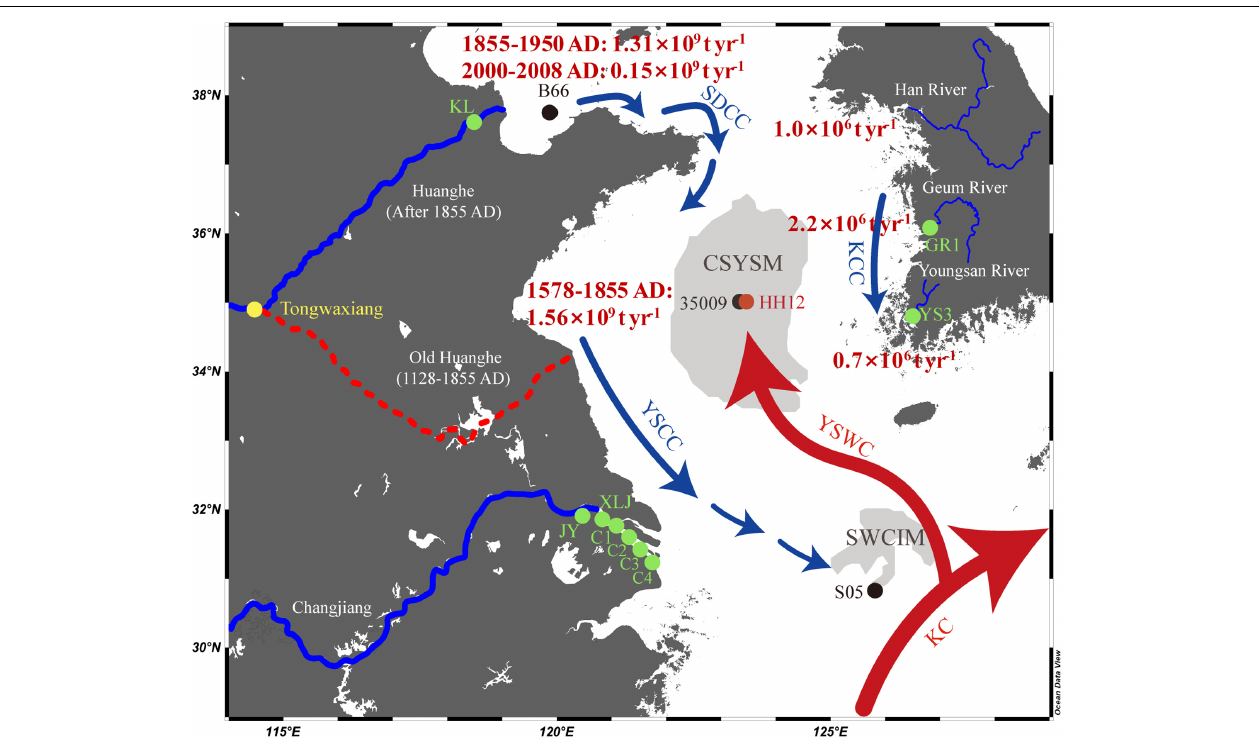
) and other core sites ( ) referred in this study (35009, Zhou X. et al., 2014; B66, Xiao et al., 2020; S05, Yang et al., 2009). FIGURE 1 | Locations of core HH12 ( The green solid dots ( ) represent river hydrological stations or sampling sites (KL, Yu et al., 2019a; XJY, JY, Wu et al., 2018; C1, C3, C5, C7, Sun et al., 2021; GR1, (cid:32) (cid:32) Kang et al., 2019; YS3, Lee et al., 2013) mentioned in this study. KL: kenli; XJY: xuliujing; JY: jiangyin. Sampling sites from the lower reach of the Han River is not (cid:32) shown because detail information was not reported by Yoon et al. (2016). The yellow solid dot ( ) represents Tongwaxiang where the Huanghe changed its course at 1855 AD. The gray areas represent Central South Yellow Sea Mud (CSYSM) and Southwestern Cheju Island Mud (SWCIM) redrawn from Li G. et al. (2014). The (cid:32) currents (indicated by arrows) include: KC, Kuroshio Current; YSWC, Yellow Sea Warm Current; YSCC, Yellow Sea Coastal Current; SDCC, Shandong Coastal Current; KCC, Korean Coastal Current. River sediment discharge was labeled in red. Sediment discharge from the Huanghe was 1.56 × 10 9 t yr − 1 during 1578-1855 AD (Wu et al., 2020), 1.31 × 10 9 t yr − 1 during 1855-1950 AD (Wang et al., 2011) and 0.15 × 10 9 t yr − 1 2000-2008 AD (Wang et al., 2011). Sediment discharges from Han River, Geum River and Youngsan River were 1.6 × 10 6 t yr − 1 , 2.2 × 10 6 t yr − 1 and 0.7 × 10 6 t yr − 1 , respectively (Qiao et al.,